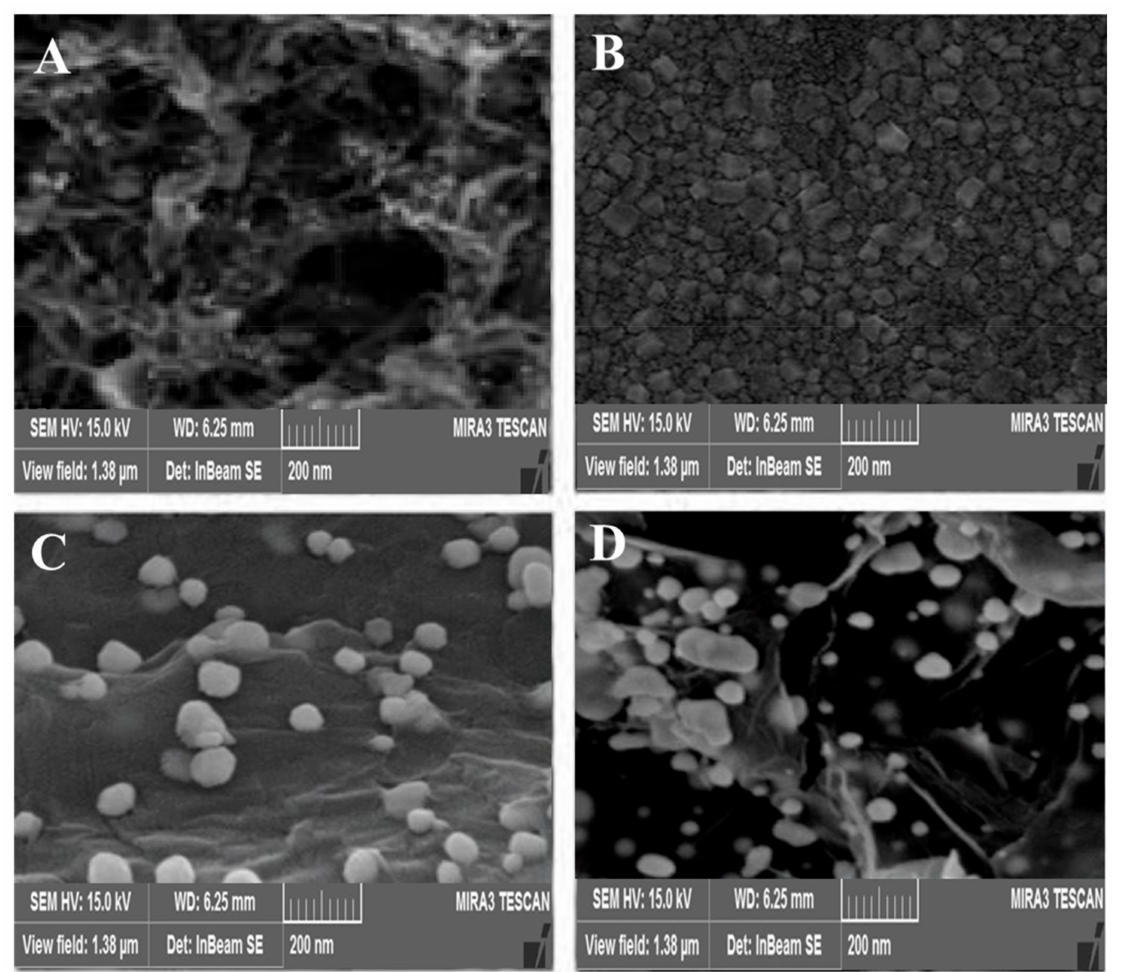
Figure 1. Scanning electron microscopy images of synthesized nanocomposites stabilized on glassy carbon electrodes MWCNTs-AuNPs ( A ), CS-AuNPs ( B ), rGO-AuNPs ( C ), and MWCNTs-AuNPs/CS- AuNPs/rGO-AuNPs ( D